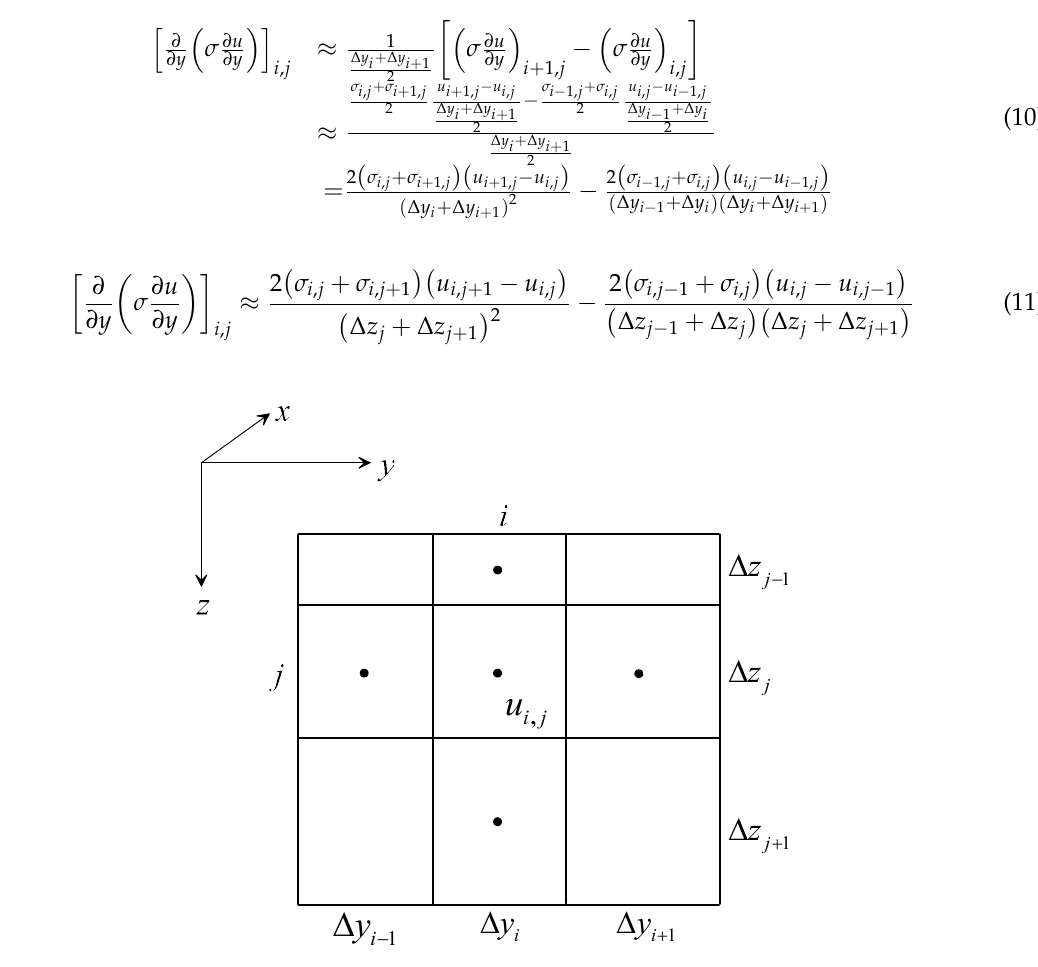
Figure 2. Discretization for 2D geo-electric model with non-uniform meshes.